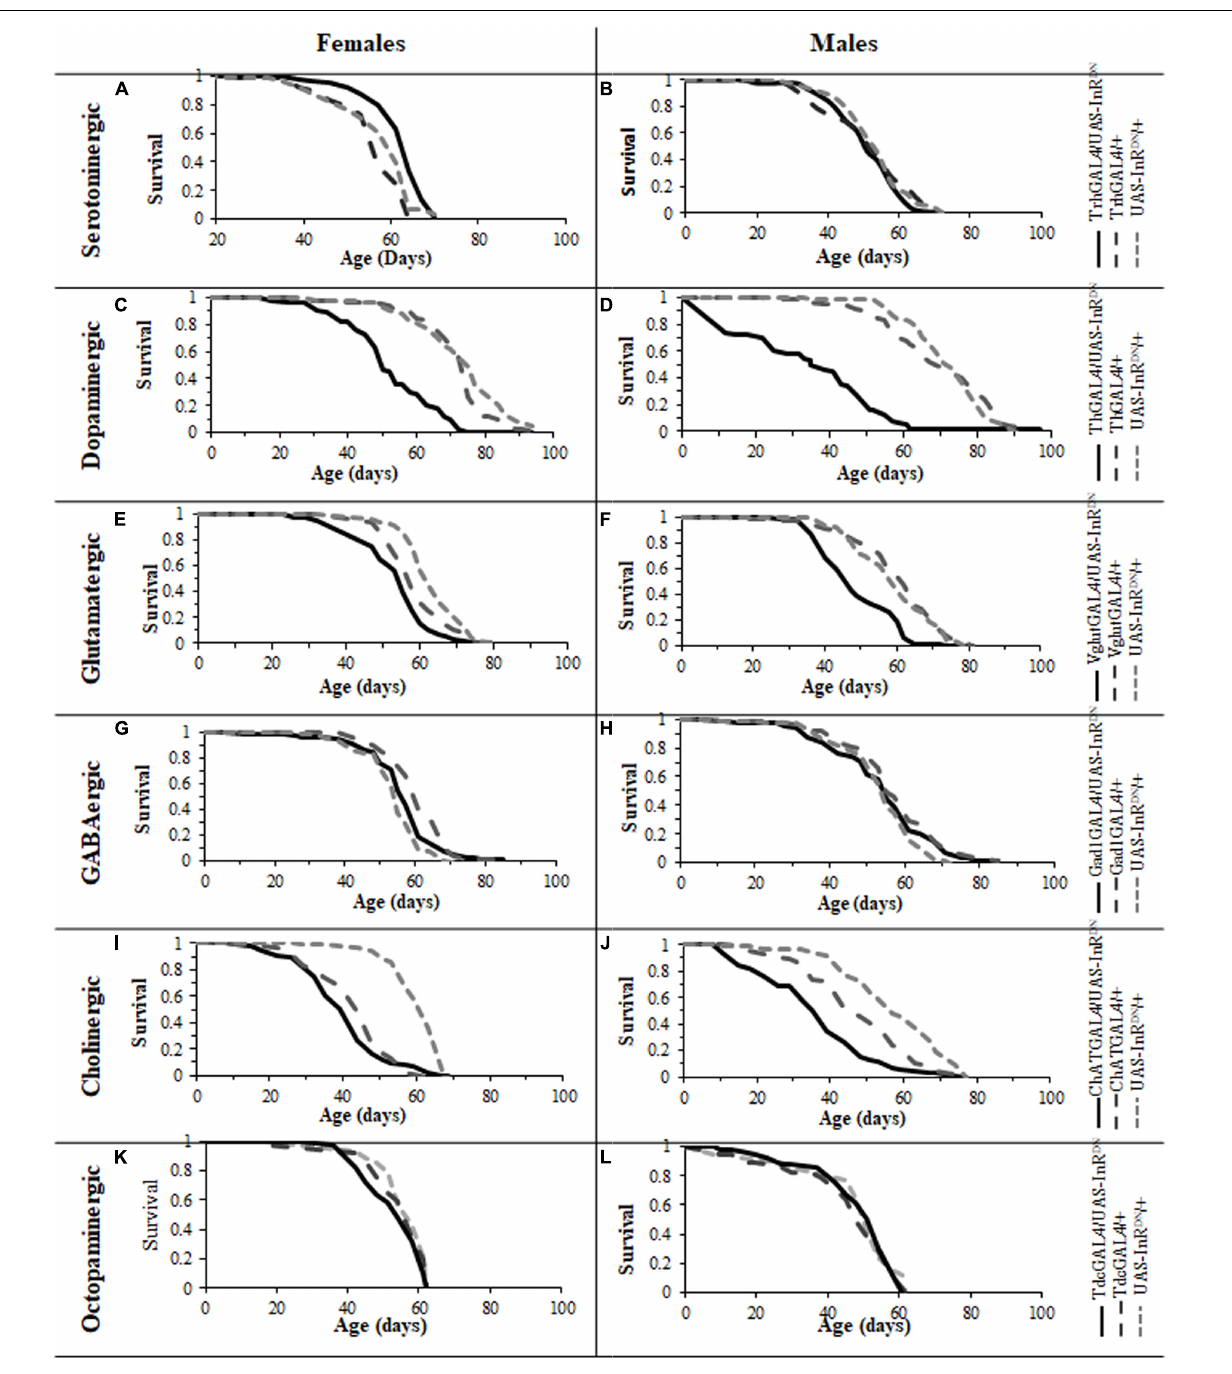
FIGURE 1 | Survival of male and female flies with neuron specific (GAL4/UAS-InR DN ) reductions in IIS. (A) Survival of TrhGAL/UAS-InR DN once mated female flies compared to TrhGAL/+ and UAS-InR DN / + controls. Median lifespans and sample sizes were: TrhGAL/UAS-InR DN = 64 days, N = 125; TrhGAL/ + = 57 days, N = 112; and UAS-InR DN /+ = 61 days, N = 113. TrhGAL/UAS-InR DN females showed an increased survival compared to both controls by log rank tests ( P < 0.0001). (B) Survival of TrhGAL/UAS-InR DN male flies compared to TrhGAL/ + and UAS-InR DN / + controls. Median lifespans and sample sizes were: TrhGAL/UAS-InR DN = 51 days, N = 91; TrhGAL/ + = 54 days, N = 87; d UAS-InR DN / + = 54 days, N = 87. (C) Survival of ThGAL/UAS-InR DN once mated female flies compared to ThGAL/ + and UAS-InR DN / + controls. Median lifespans and sample sizes were: ThGAL/UAS-InR DN = 49 days, N = 150; ThGAL/ + = 73.5 days, N = 148; and UAS-InR DN / + = 73.5 days, N = 144. ThGAL/UAS-InR DN females showed a decreased survival compared to both controls by log rank tests ( P < 0.001). (D) Survival of ThGAL/UAS-InR DN male flies compared to ThGAL/ + and UAS-InR DN / + controls. Median lifespans and sample sizes were: ThGAL/UAS-InR DN = 34 days, N = 149; ThGAL/ + = 73.1 days, N = 153; and UAS-InR DN / + = 74.5 days, N = 153. ThGAL/UAS-InR DN males showed a decreased survival compared to both controls by log rank tests (P = ??). (E) Survival of VglutGAL/UAS-InR DN once mated female flies compared to VglutGAL/ +